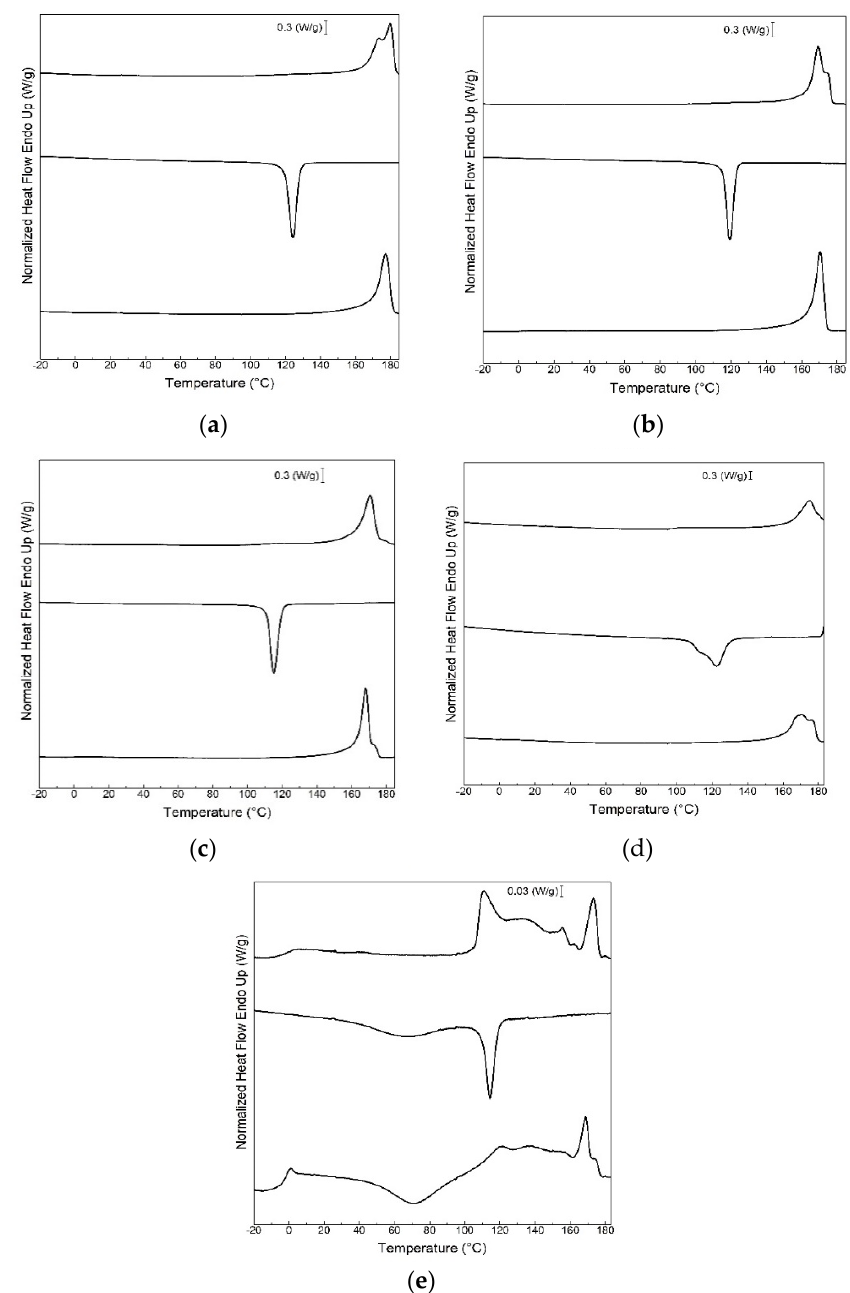
Figure 3. Differential scanning calorimetry (DSC) curves during first heating, cooling, and second